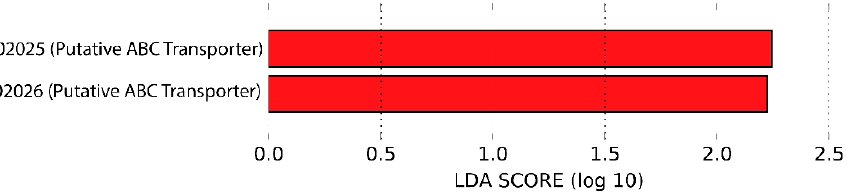
Figure 3. Predicted functional composition of metagenomes based on 16SrRNA gene sequencing data. LEfSe based on the PICRUSt2 dataset revealed differentially enriched metabolic pathways associated with PPARGC1A genotypes 1 and 2 (PPARGC1A-1 (red); PPARGC1A-2 (green)). LDA: linear discriminant analysis.